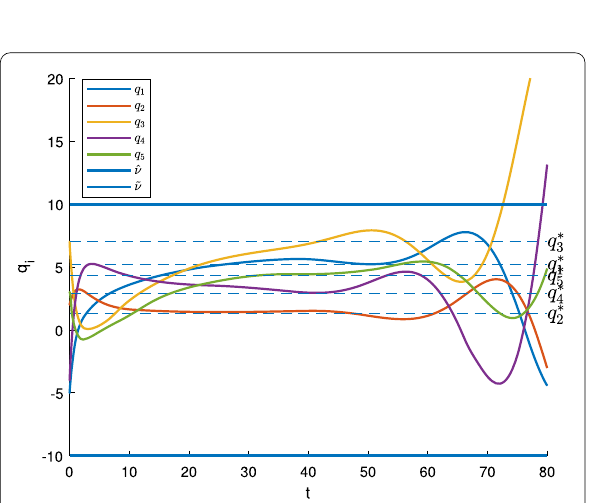
Figure 7 The tracking errors of generator systems to the reference path generated by the cooperative game optimizer